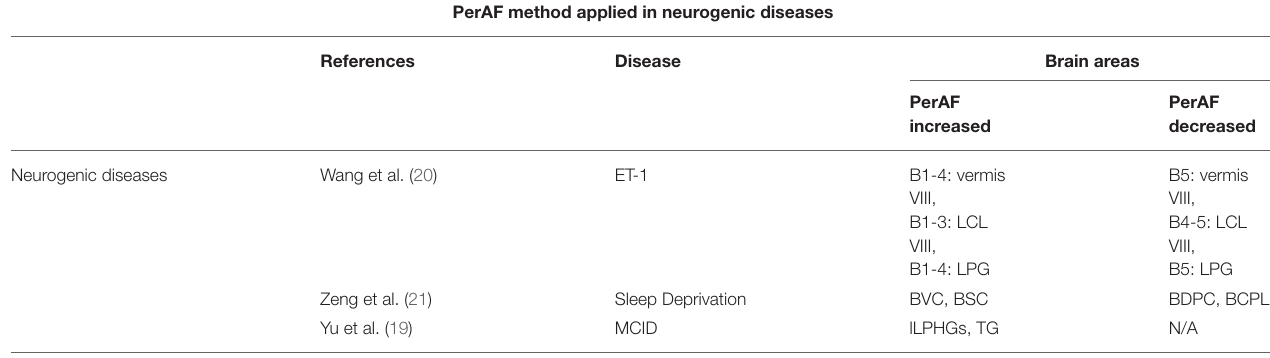
TABLE 4 | The PerAF methods applied in neurogenic diseases.